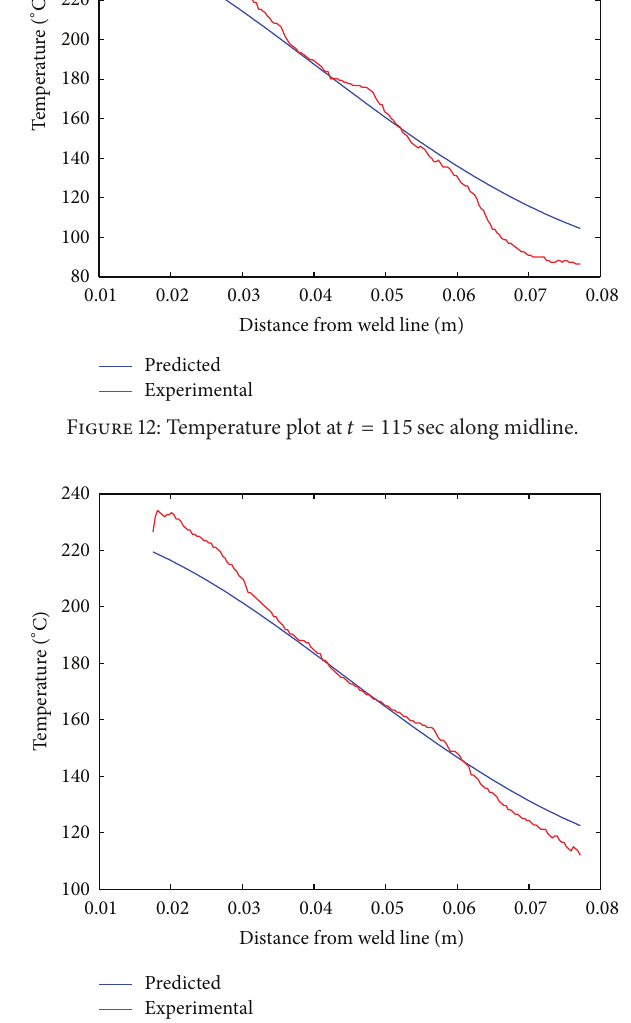
Figure 13: Temperature plot at 𝑡 = 145 sec along midline.